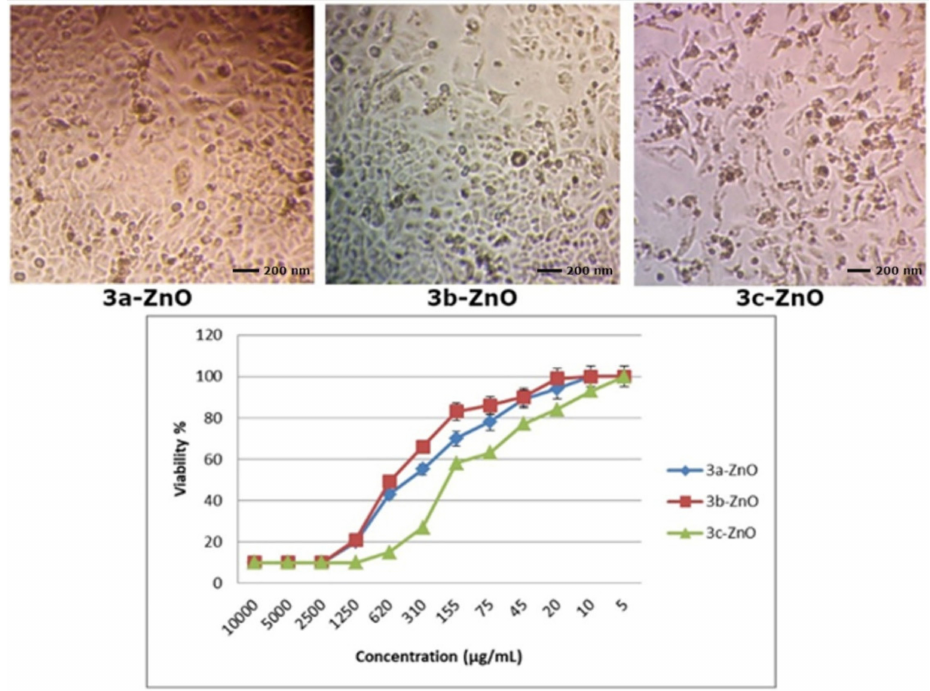
Figure 10. Cytotoxic effect of the synthesized